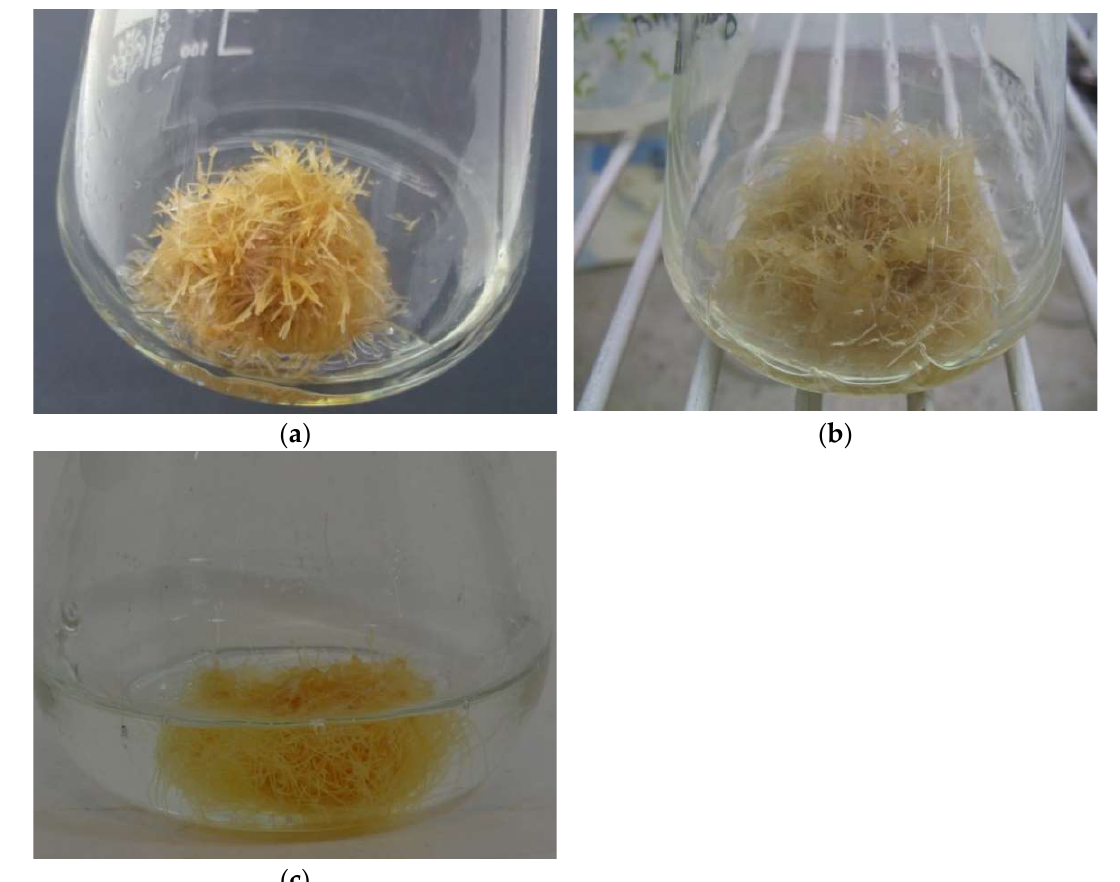
Figure 2. Three selected hairy root lines of Polyscias filicifolia obtained as a result of transformation performed with Agrobacterium rhizogenes ATCC 15834 strain. Hairy roots were cultivated in liquid hormone-free MS medium: ( a ) K-1 line; ( b ) K-3 line; ( c ) K-5 line.